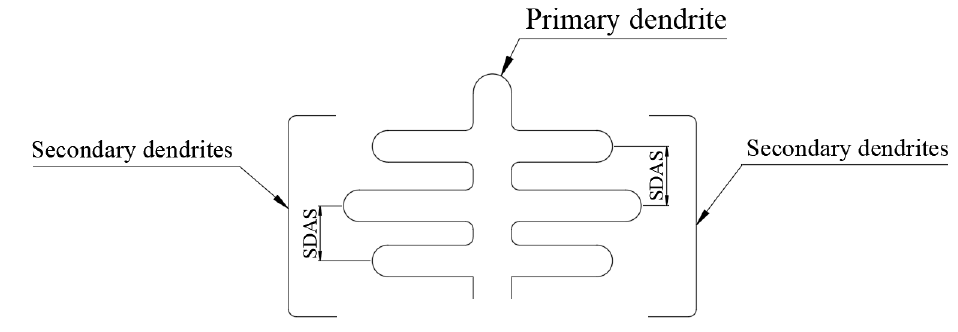
Figure 1. SDAS definition: the distance between two secondary